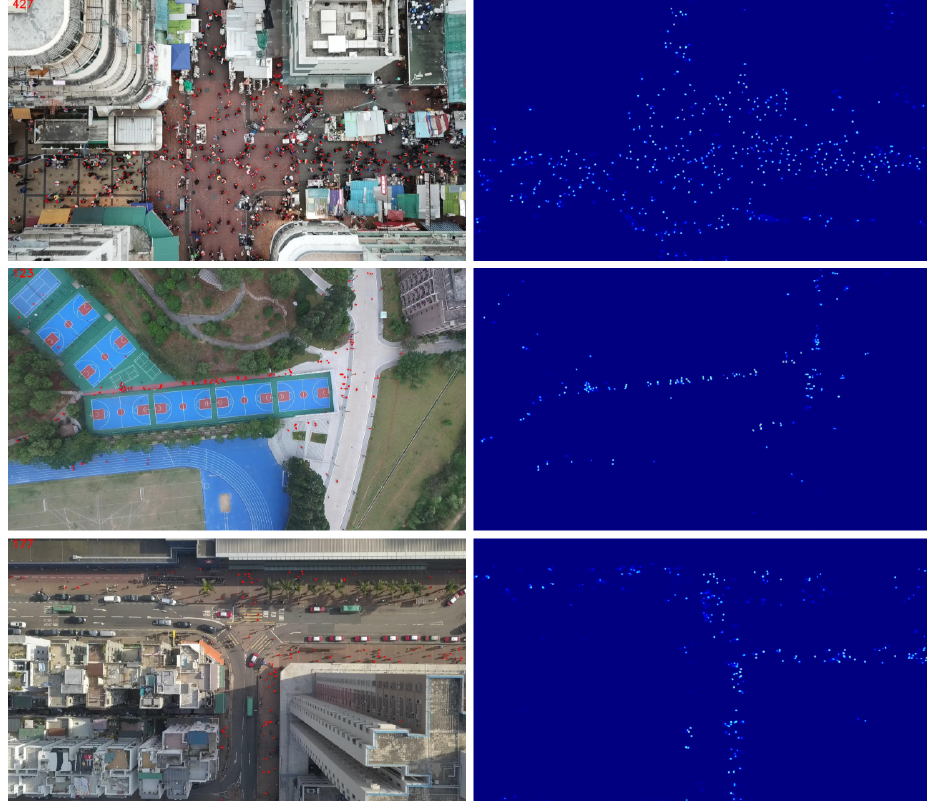
Figure 9. The visual effect of the algorithms. Left column: the input image plus the estimated human positions. Right column: estimated density